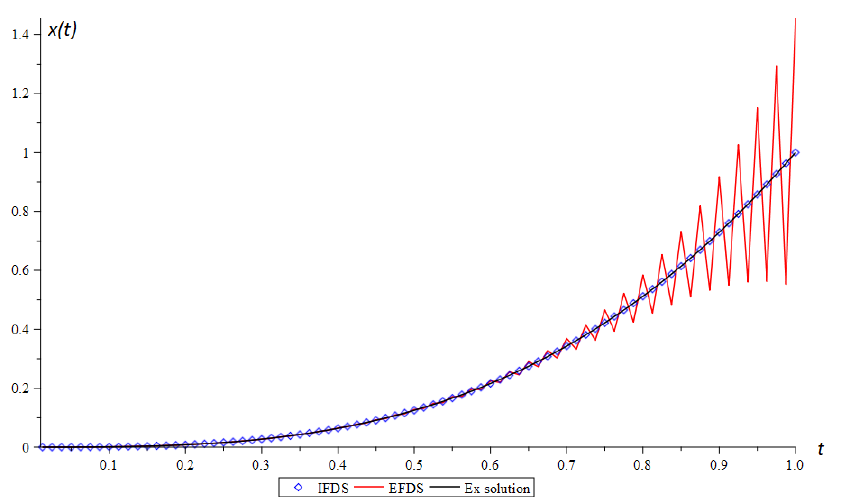
Figure 2. ( a ) Error ε , ( b ) computational accuracy α .